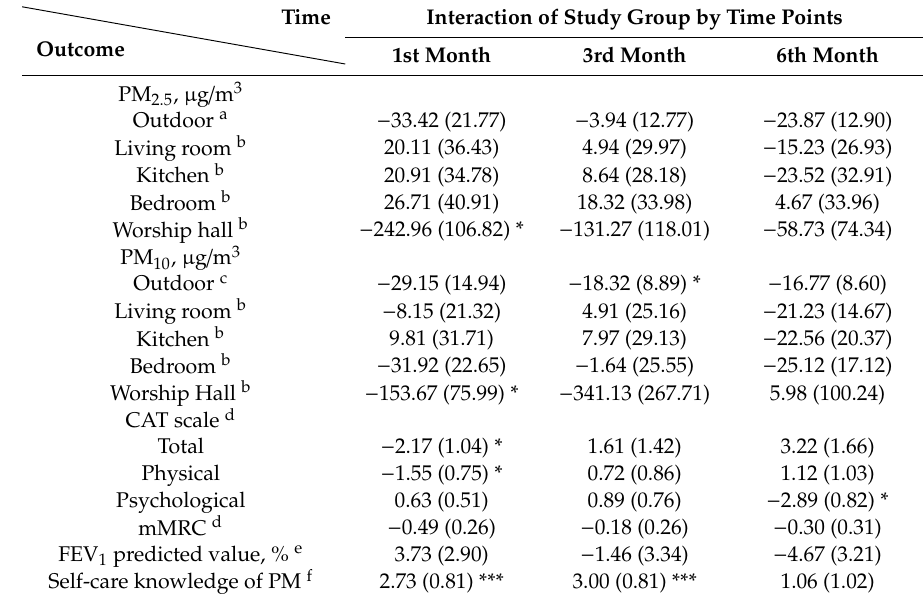
Table 3. Summary of generalized estimating equation # ( n =